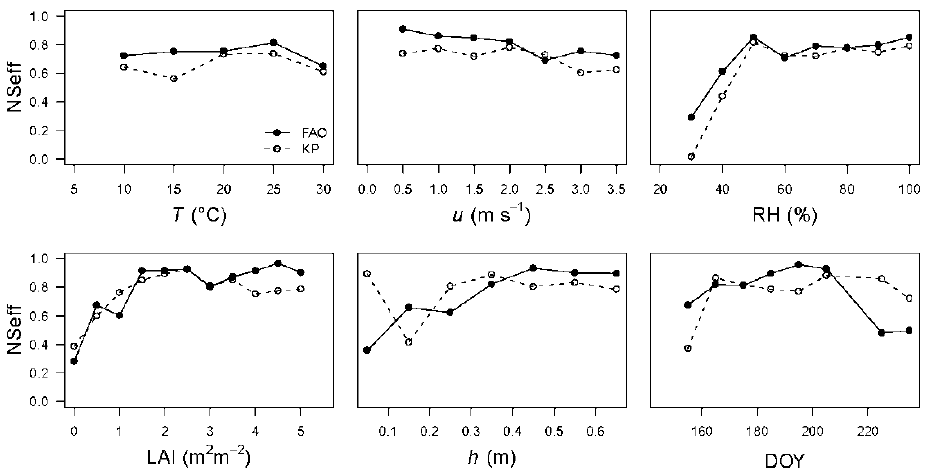
Figure 6. Nash-Sutcliffe model efficiency coefficient (NSeff) of simulated evapotranspiration by PM-FAO approach (solid line with closed circle) and PM-KP approach (dash line with open circle) against air temperature ( T ), wind speed ( u ), relative humidity (RH), leaf area index (LAI), plant height ( h ), and day of the year (DOY), for the potato field.